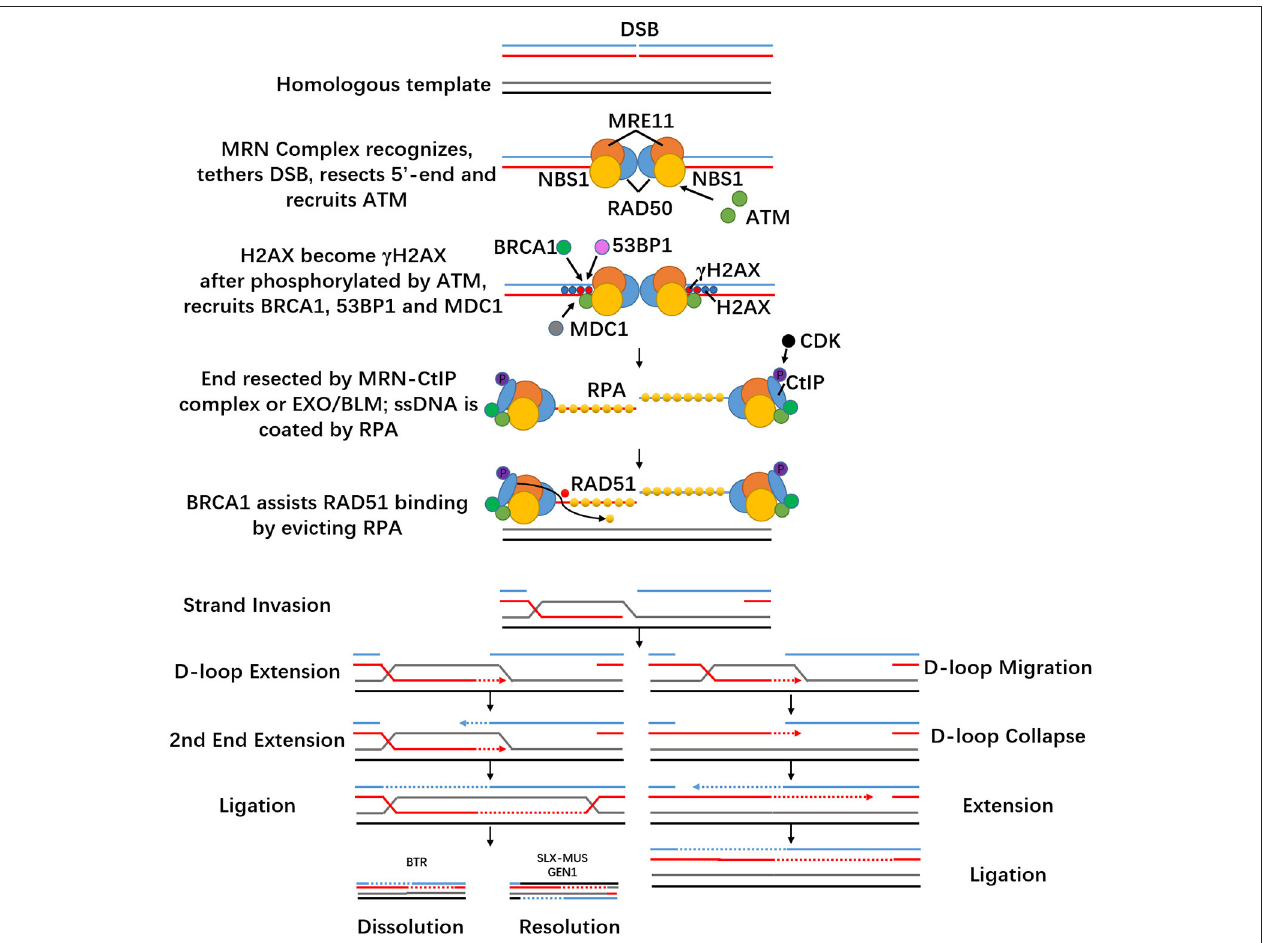
FIGURE 2 | Homology-directed repair HDR. When DSB happens in the S- or G2-phase of the cell cycle and homologous sequence exists near the DSB, DSB can be handled through the HDR pathway if the ends of the DSB are resected. Ends will be coated with various proteins and then invade homologous duplex DNA to form an exchange intermediate: the D-loop structure. Most D-loop structures will be extended by DNA synthesis (dashed arrow). The second end pairs to the D-loop and starts extension. This pathway is called the double Holliday junction pathway. Ligation generates the characteristic double Holliday junction, which may be cleaved by HJ resolvases into either crossover or non-crossover products. The synthesis-dependent strand annealing pathway is illustrated on the right. After D-loop formation, replication and branch migration take place which can lead to D-loop translocation. The translocating D-loop is unstable and collapses easily. After collapse, the extended first end may anneal to complementary ssDNA in the resected second end. Replicative extension of both ends and ligation generates non-crossover